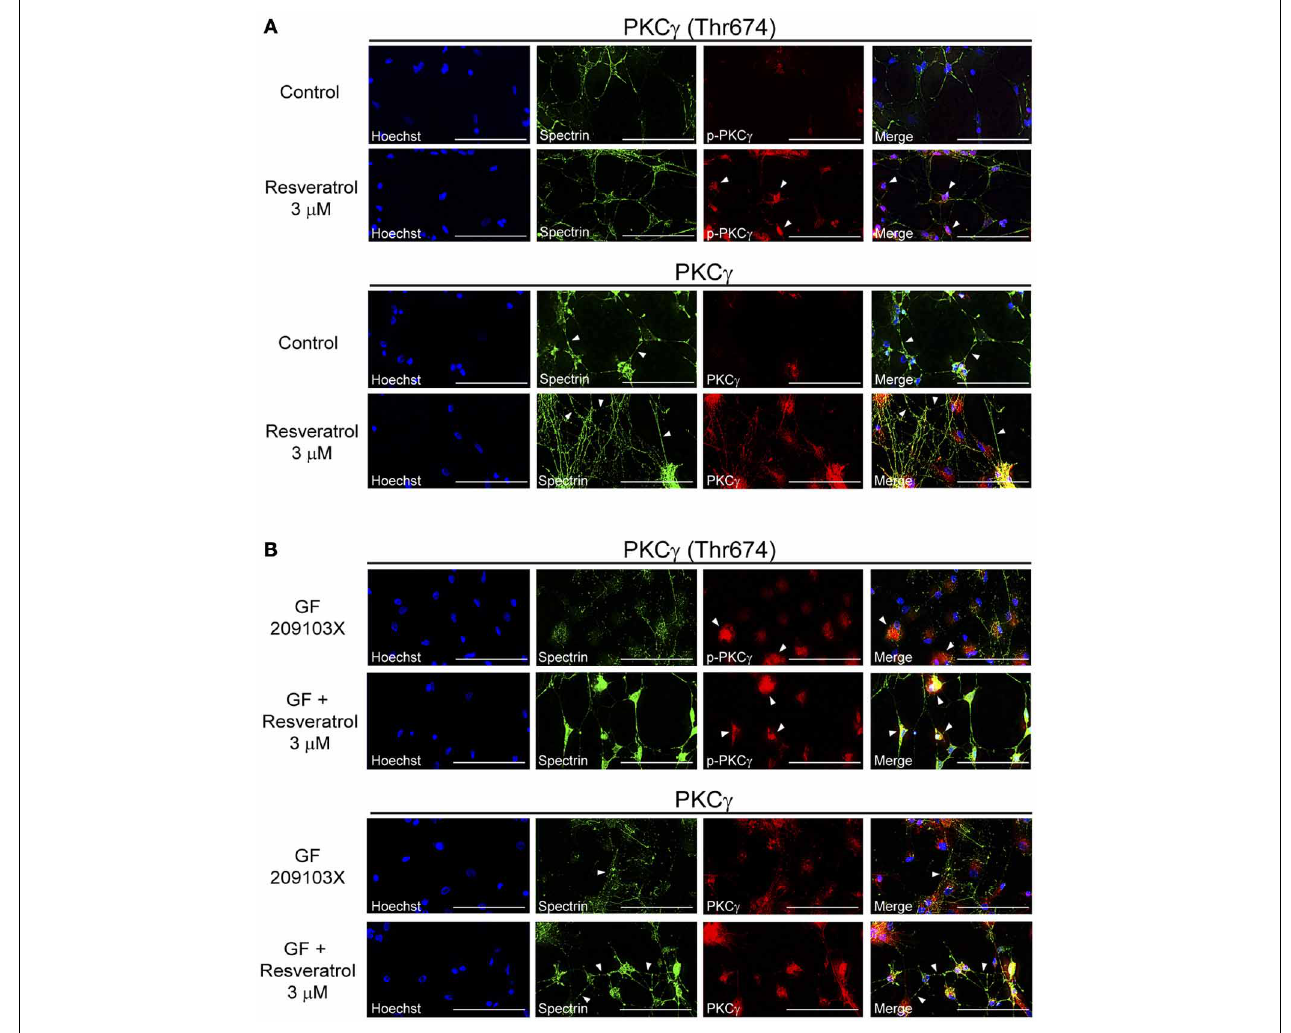
FIGURE 2 | Resveratrol treatment increases PKC γ activation, neuronal interconnections and maintains cytoskeleton integrity. (A) Application of resveratrol (3 μ M) activated PKC γ by phosphorylation at threonine 674 residue, increased PKC γ expression and neuronal interconnections in hippocampal cells. (B) Treatment with the PKC inhibitor GF 109203X (5 μ M)